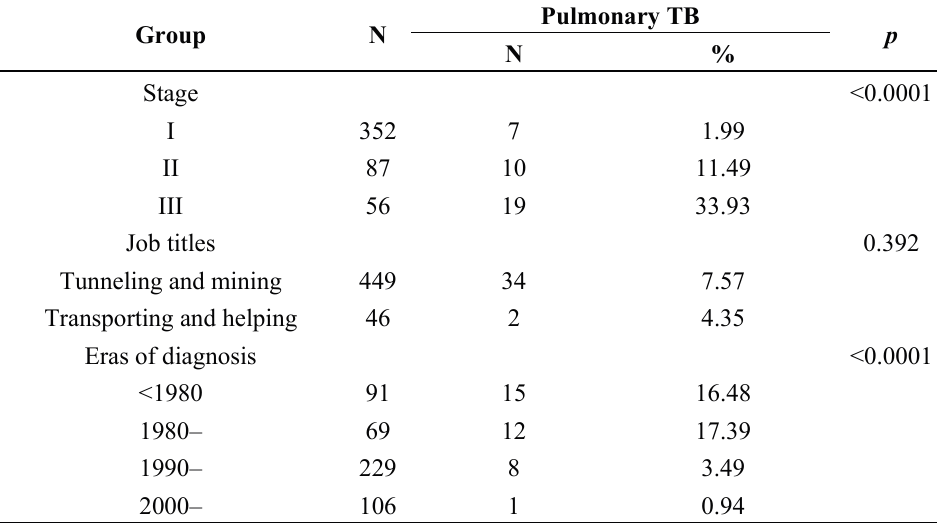
Table 5. CWP with pulmonary tuberculosis complication.